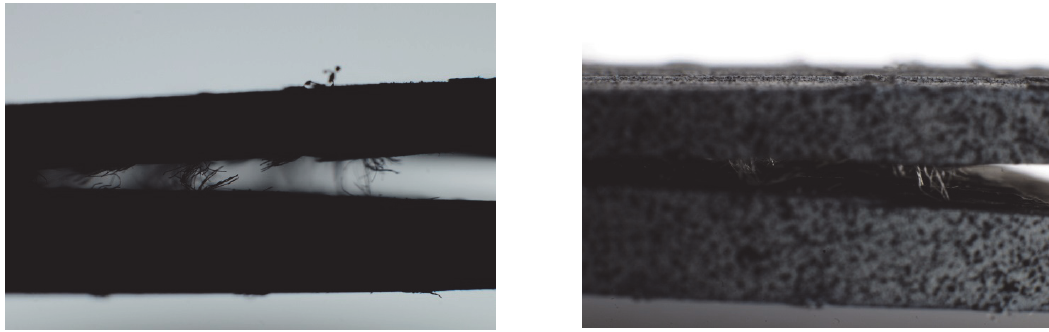
Figure 7: Interlaminar failure of the 3 mm carbon adherend.